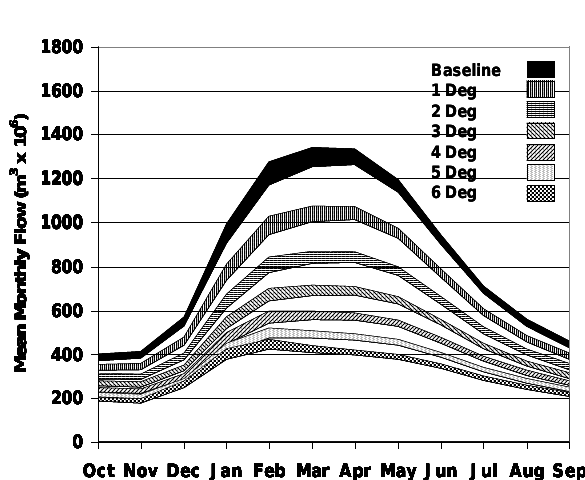
Oct Nov Dec Jan Feb Mar Apr May Jun Jul Aug Sep Fig. 10. Mean calendar monthly flow for the Okavango River at Figure 10 Mean calendar monthly flow for the Okavango River at Mukwe based 925 Mukwe based on a 1000 member ensemble simulation for the 6 on a 1000 member ensemble simulation for the 6 HADCM3 scenarios, 926 compared to the baseline simulation. 927 HADCM3 scenarios, compared to the baseline 928